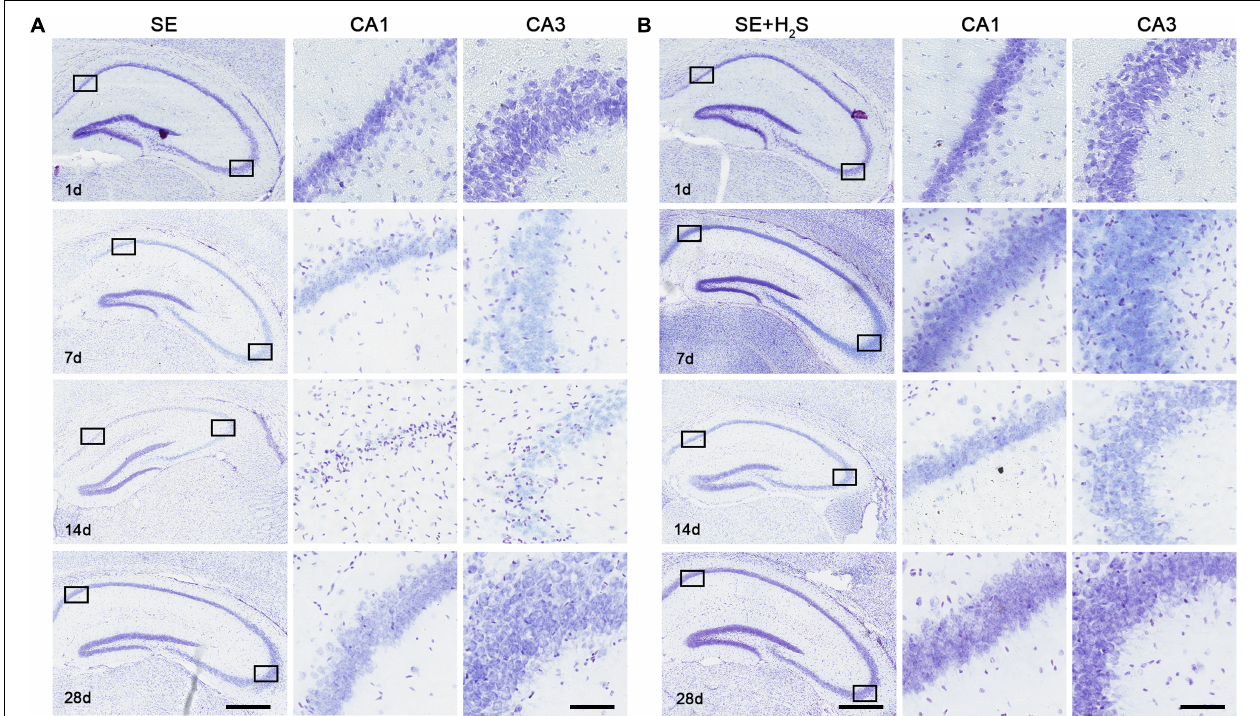
FIGURE 2 | The H 2 S donor reduced neuronal damage in the hippocampus of SE mice. (A,B) Nissl staining of hippocampus at different time points (1d, 7d, 14d, 28d) after status epilepticus in SE group and SE+H 2 S group. Scale bars, 25 µ m in CA3 and 200 µ m in hippocampus. n = 5 per